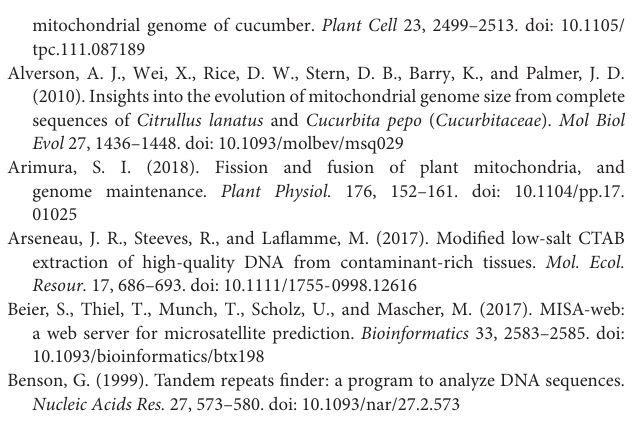
Supplementary Figure S1 | The distribution of contig length and read depth in the de novo assembly by Newbler v3.0. Supplementary Figure S2 | Comparison of P. tremula and P. simonii mitochondrial genomes. PsChr1, PsChr2, and PsChr3 represent the three circular molecules of P. simonii mitogenome,